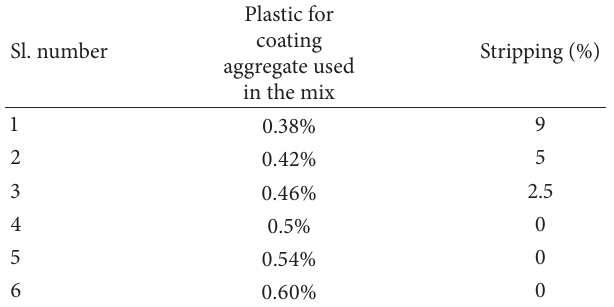
Table 8: Stripping value test